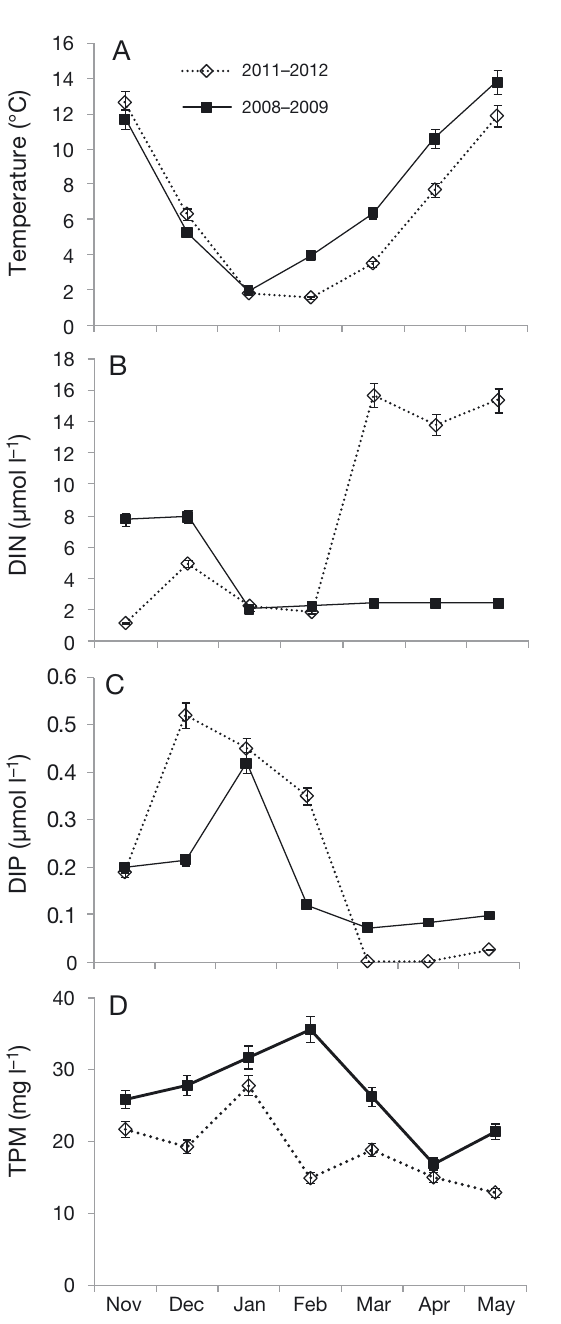
Fig. 3. Observed environmental data (mean ± SE) for the pe- riods 2008−2009 and 2011−2012 in Sanggou Bay, China, that were used to force the kelp growth model. (A) Temperature, (B) dissolved inorganic nitrogen (DIN), (C) dissolved inor- ganic phosphorus (DIP), and (D) total suspended particulate materials (TPM) Fig. 5. Observed individual dry weight of cultured kelp The simulated and observed values for 2011−2012 vs. values simulated by the kelp growth model for the peri- and for 2008–2009 were plotted in Fig. 5. For ods 2011−2012 (R 2 = 0.995, p < 0.001) and 2008−2009 (R 2 = 2001−2012, y = x regression of the data revealed a sig- 0.969, p < 0.001). For a perfect fit all points would be on the nificant correlation (R 2 = 0.996; ANOVA, p < 0.001). line y =